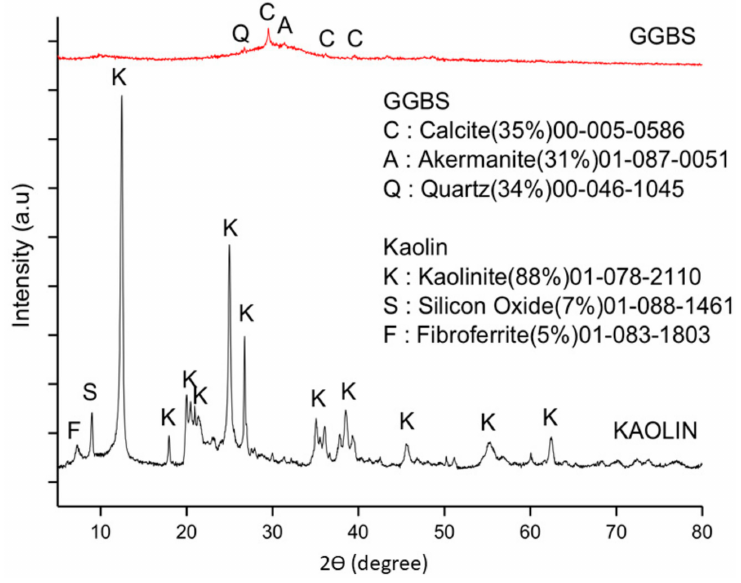
Figure 3. Phase composition of kaolin and ground granulated blast furnace slag (GGBS).